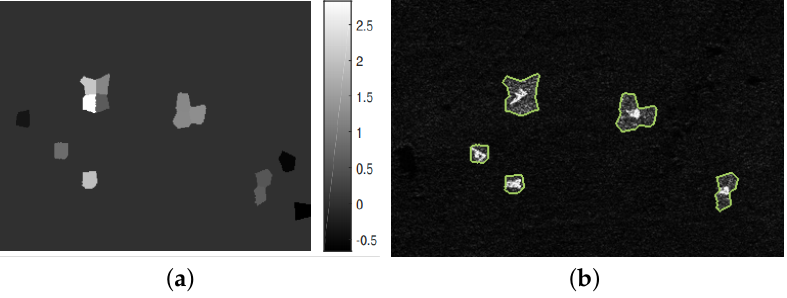
Figure 7. Local graph model detection. ( a ) The difference of the shortest distance from the superpixel to the background seed and the target seed; ( b ) Partial detection